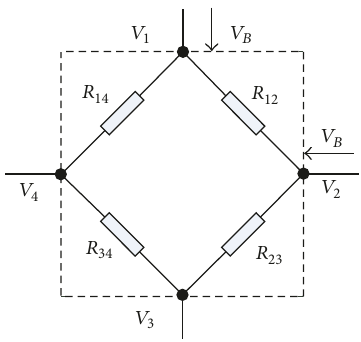
Figure 2: Hall element Wheatstone bridge model.